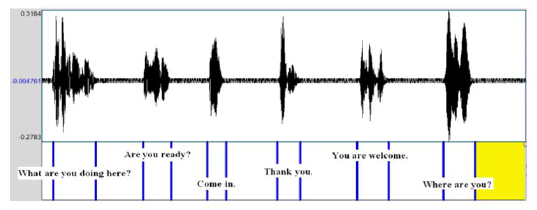
Fig. 1. Example of speech analysis with the PRAAT